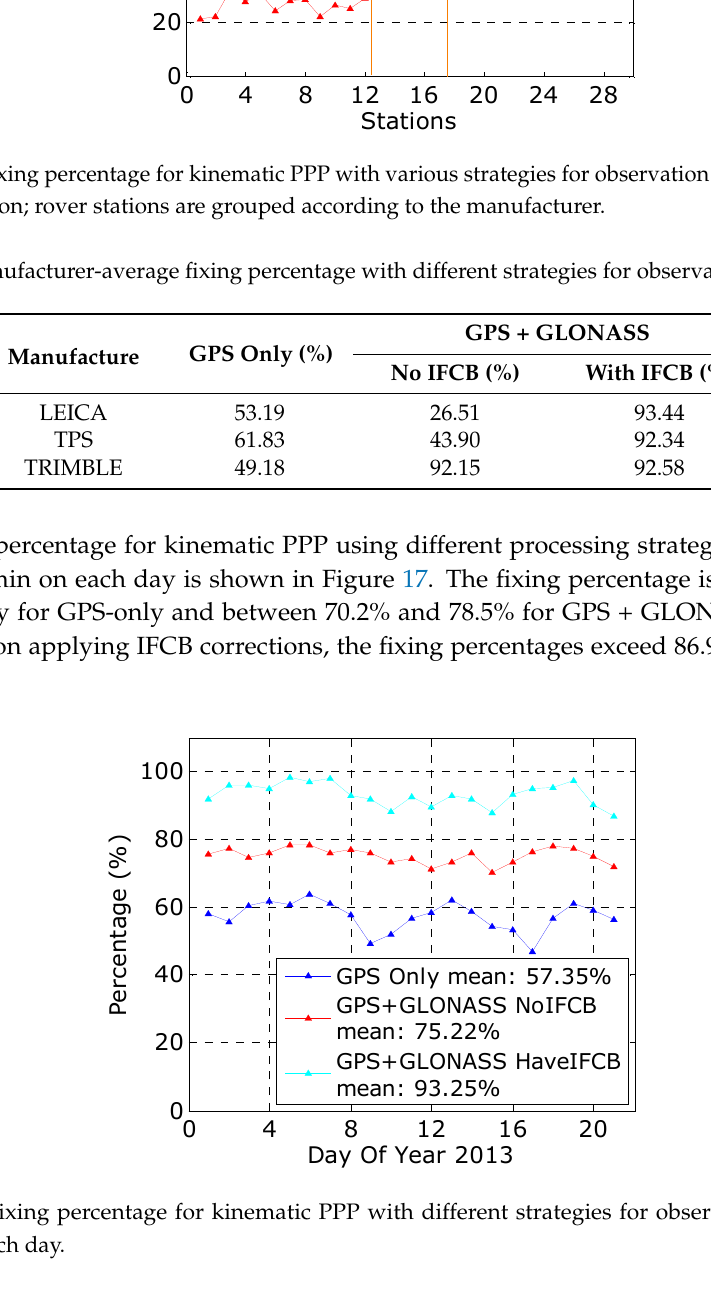
Table 6. Position RMS (cm) for kinematic ambiguity fixed PPP solutions.